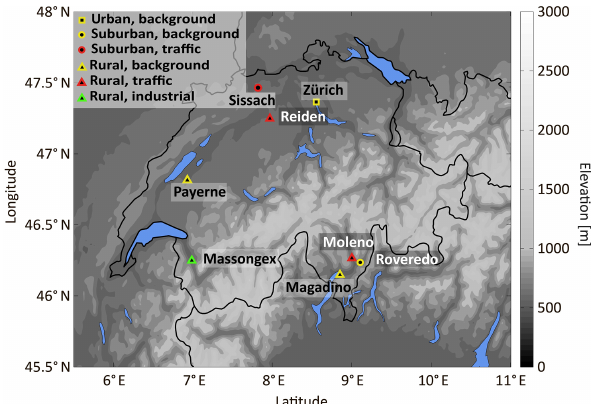
Figure 1. Location of the different stations in Switzerland investi- gated in this